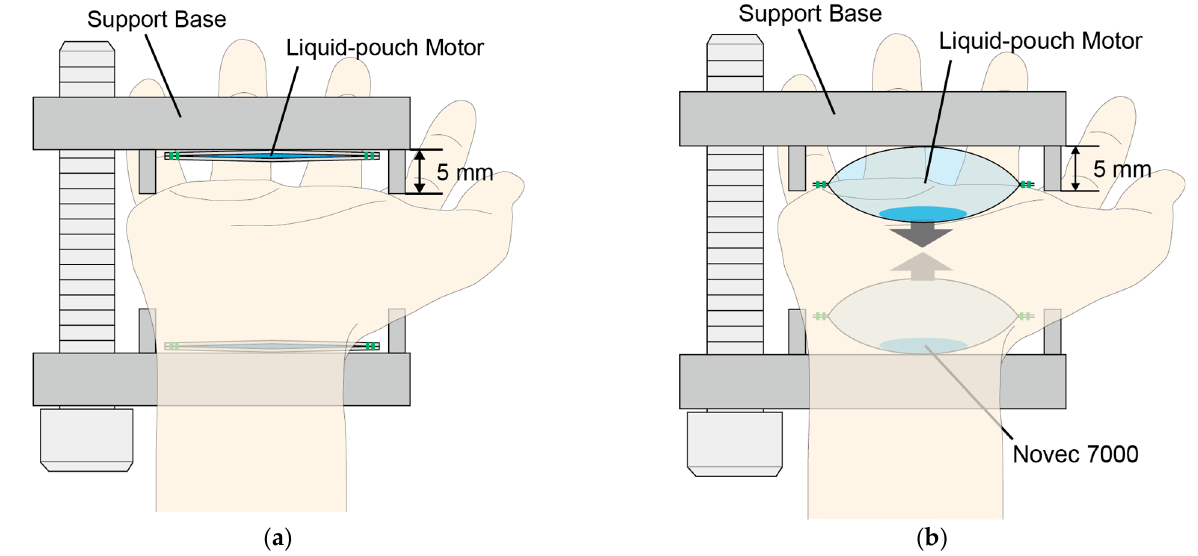
Figure 3. Mechanism of applying pressure onto palm with pouch actuators: ( a ) before heating and ( b ) after heating.